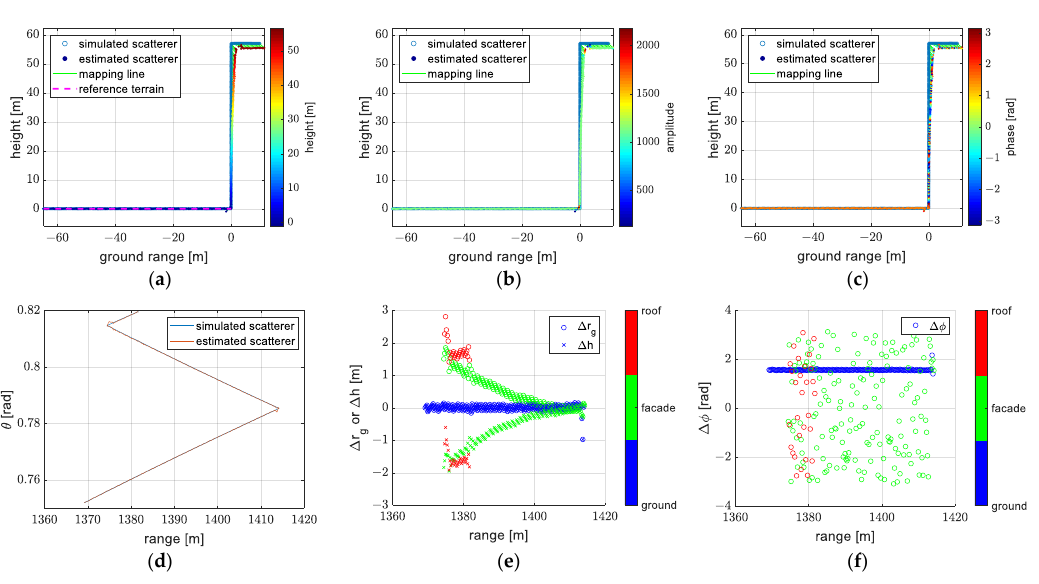
Figure 11. The reconstruction obtained using model 2 (the first approximate form of the planar wavefront model): ( a ) reconstruction with colors denoted as height, ( b ) reconstruction with colors denoted as amplitude, ( c ) reconstruction with colors denoted as phase, ( d ) the off-nadir angle of the reconstruction, ( e ) the error of the ground range and height, ( f ) the error of the